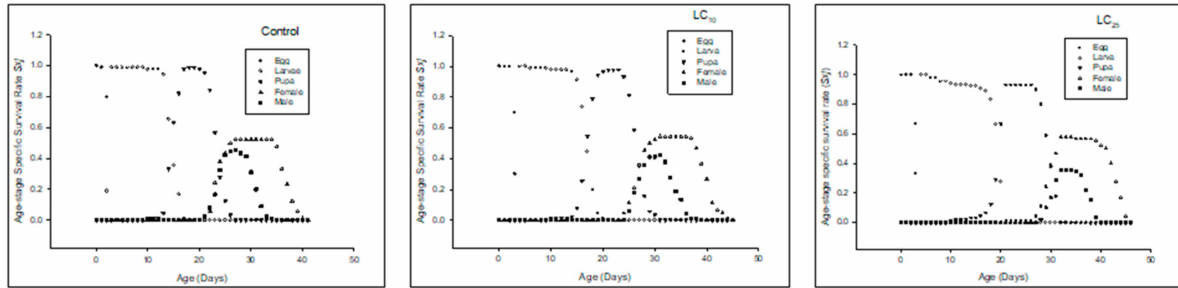
Figure 1. Age stage-specific survival rate ( s xj ) of the F 0 generation in Spodoptera frugiperda . Age-stage-specific life expectancy( e xj ) was higher in LC 10 and LC 25 -treated insects than in the control (Figure 2).